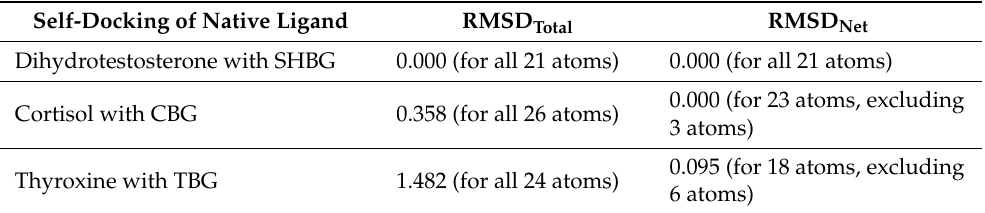
Figure 3. Molecular docking of nicotine and its three important metabolites to the ligand-binding site of sex-hormone-binding globulin (SHBG). SHBG is in surface representation colored light or- ange. The ligands are shown in stick representation together in the binding site for easy comparison of the binding poses. The backbones of the compounds are colored differently: native ligand (dihy- drotestosterone) in white, nicotine in magenta, cotinine in cyan, trans-3 ′ -hydroxycotinine in green, and 5 ′ -hydroxycotinine in yellow. The heteroatoms of the compounds oxygen (O) and nitrogen (N) are in blue and red colors, respectively. Table 2. The binding strength scores for nicotine and its metabolites in complex with sex-hormone- binding globulin (SHBG). The ‘K d ’ denotes the dissociation constant. The binding energy and pK d or − log (K d ) values were calculated using X-Score. Lower (more negative) binding energy or Dock/Grid score and higher dissociation constant denote better docking. Ligands Interacting with SHBG